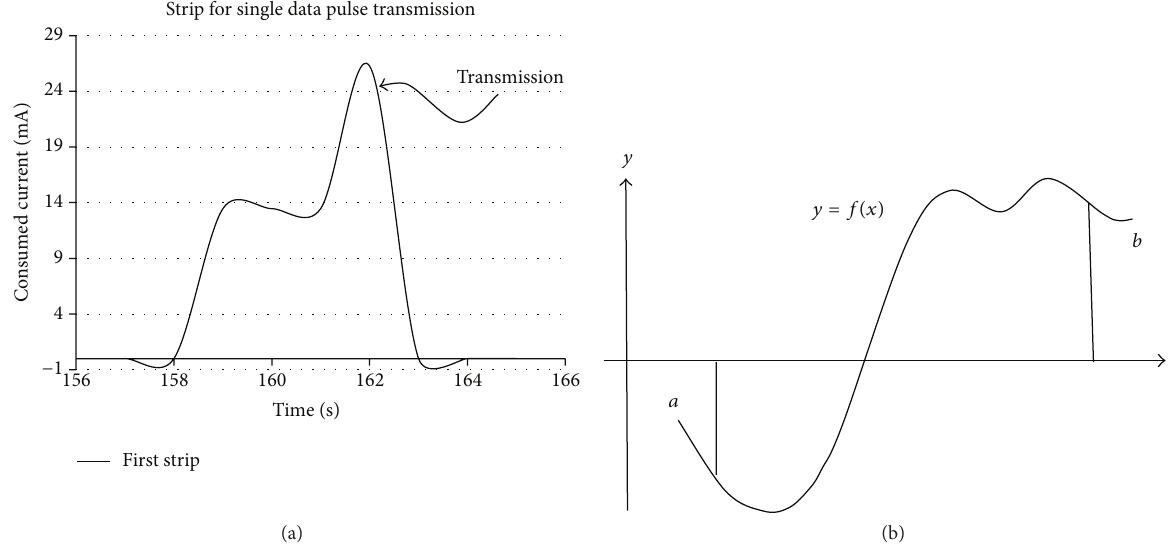
Figure 1: (a) Example of current consumption of a WSN NODE for transmitting a single data pulse to the adjacent WSN Router. (b) Arbitrary continuous functions for a close interval of 𝑎 to 𝑏 .